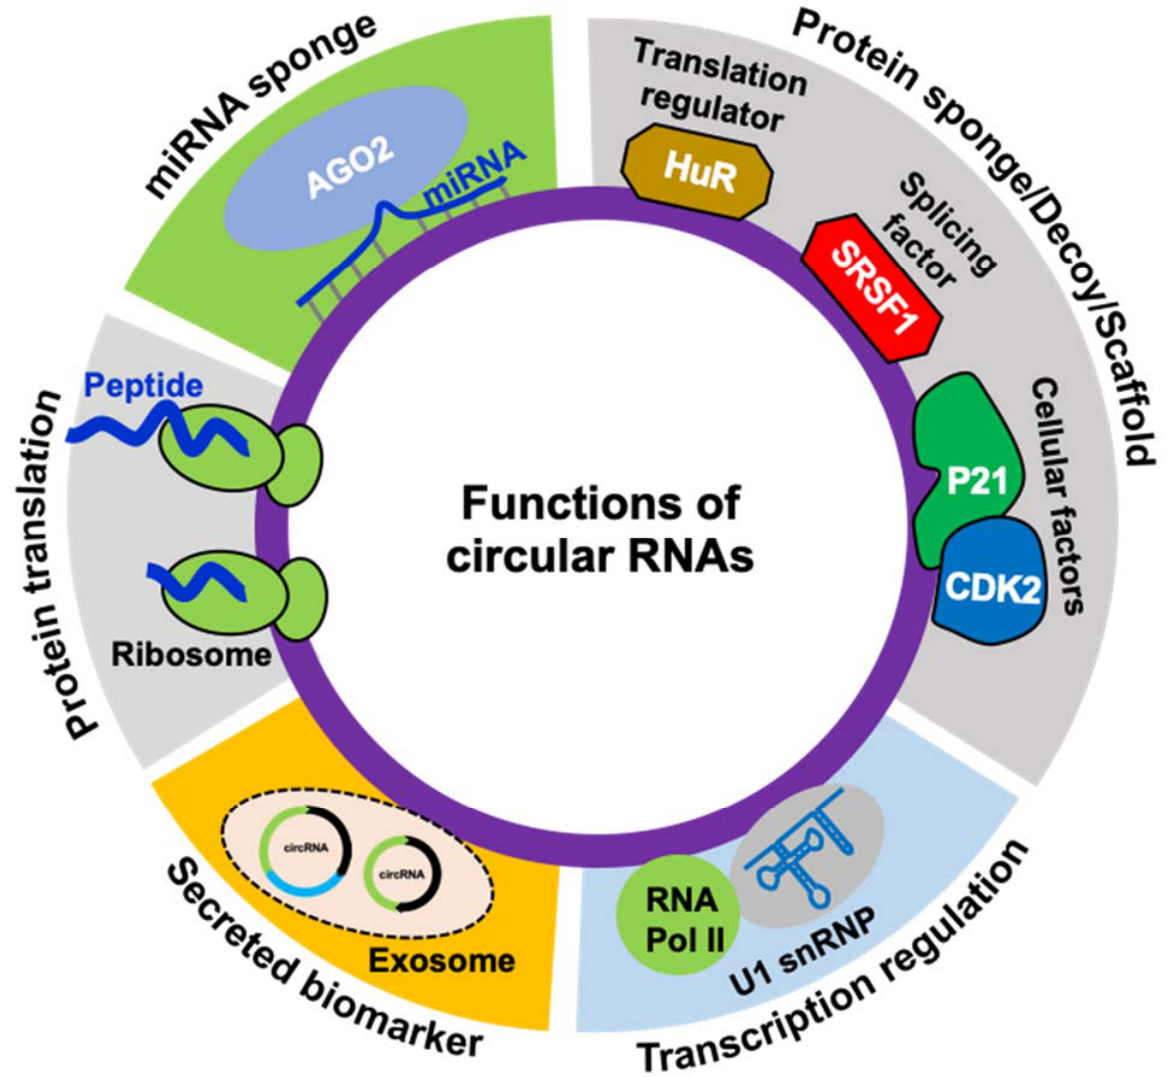
Figure 2. Schematic representation of known functions of circRNAs.